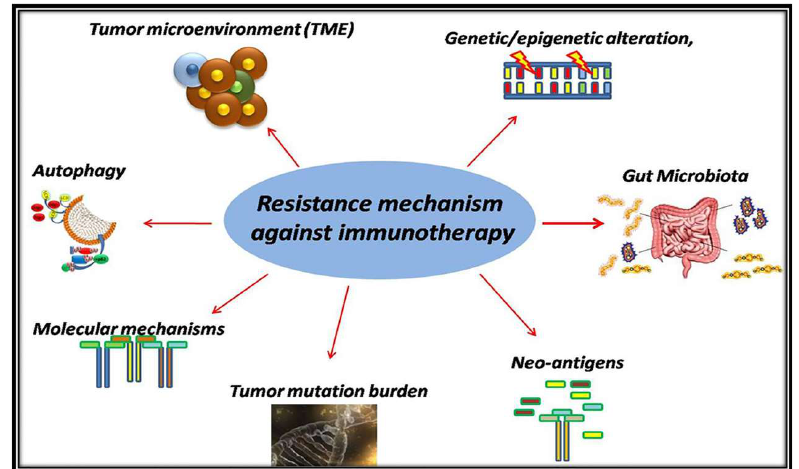
Figure 1. The predominant mechanisms of immunotherapy resistance in solid tumors. Several potential tumor-related mechanisms have already been identified as resistance mechanism